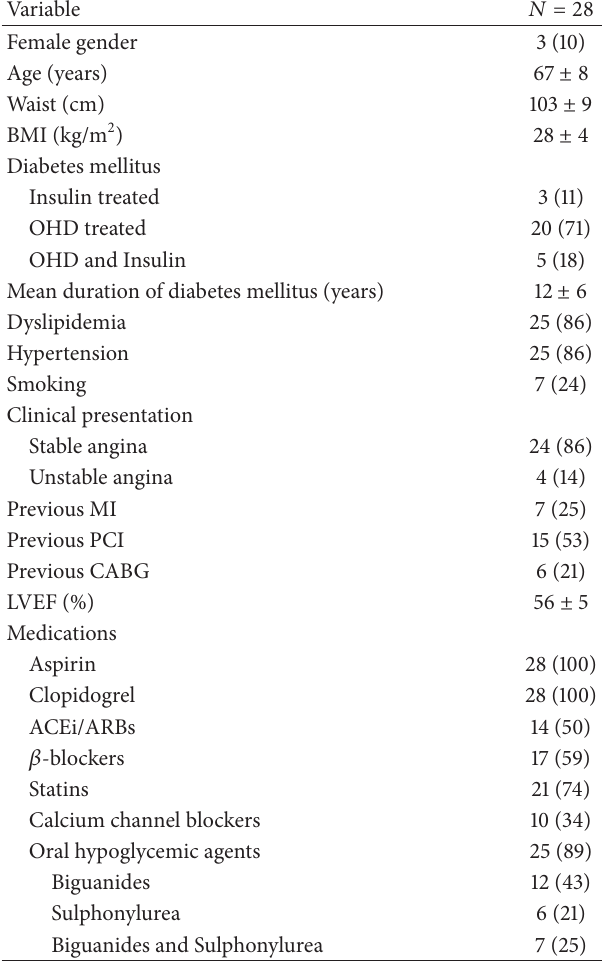
Table 2: Baseline population